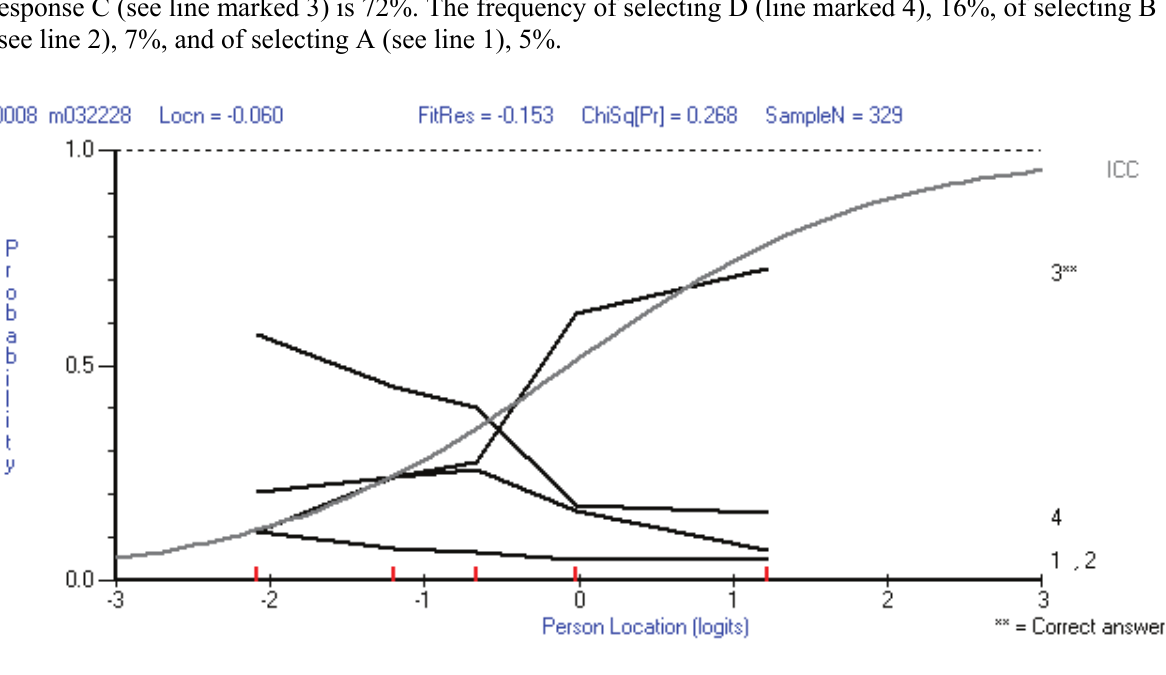
Figure 2 : Item 8 distracter analyses for quintile